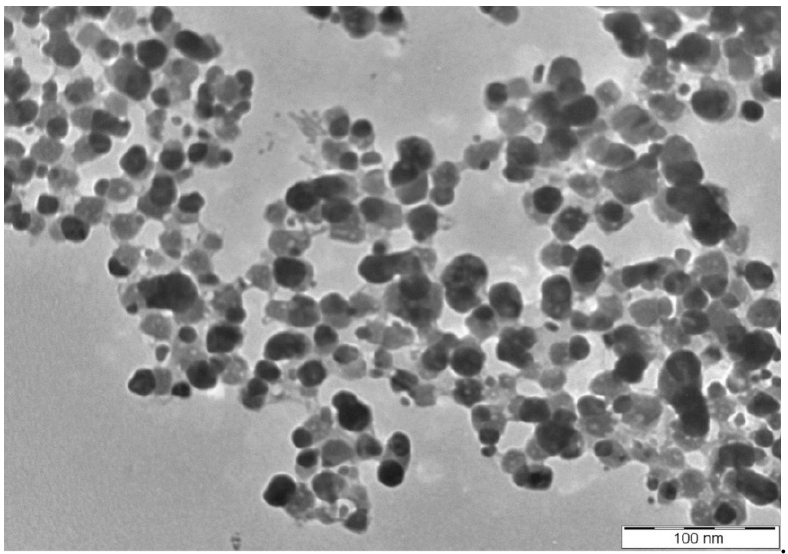
Figure 4. TEM image of Eh-AgNPs.